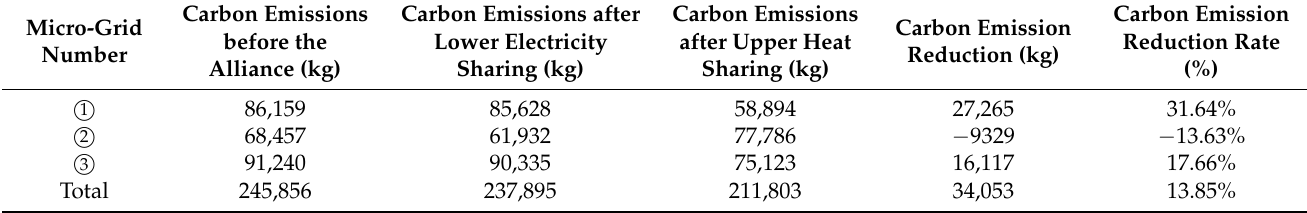
Table A4. Carbon emission reduction benefit analysis table of electric heating double-layer sharing in multi-micro-grid